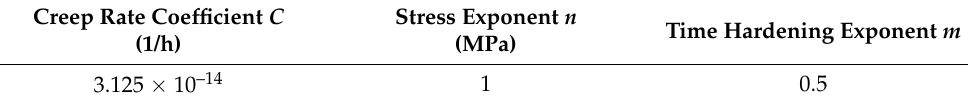
Table 3. Creep constants of constantan alloy.